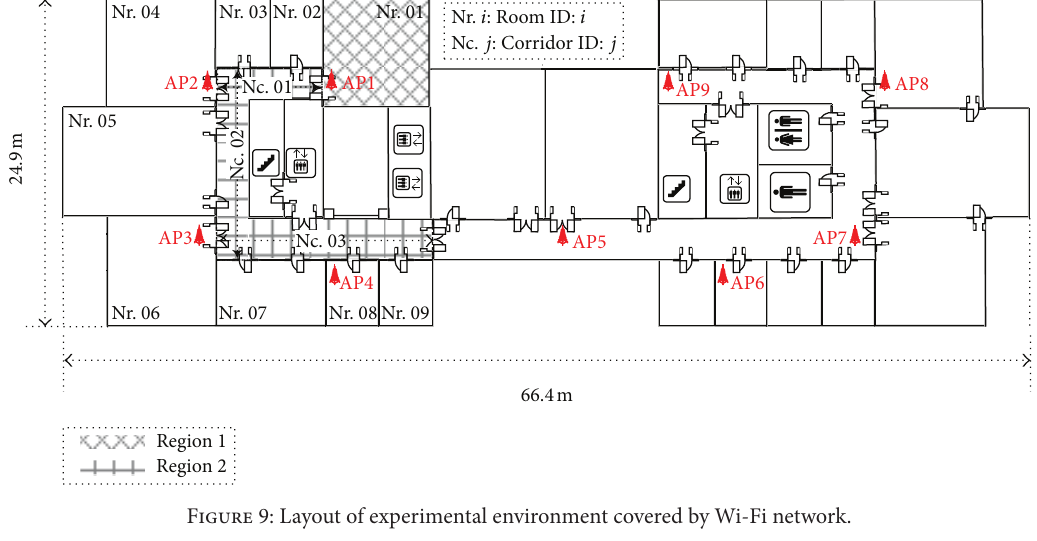
Figure 9: Layout of experimental environment covered by Wi-Fi network.